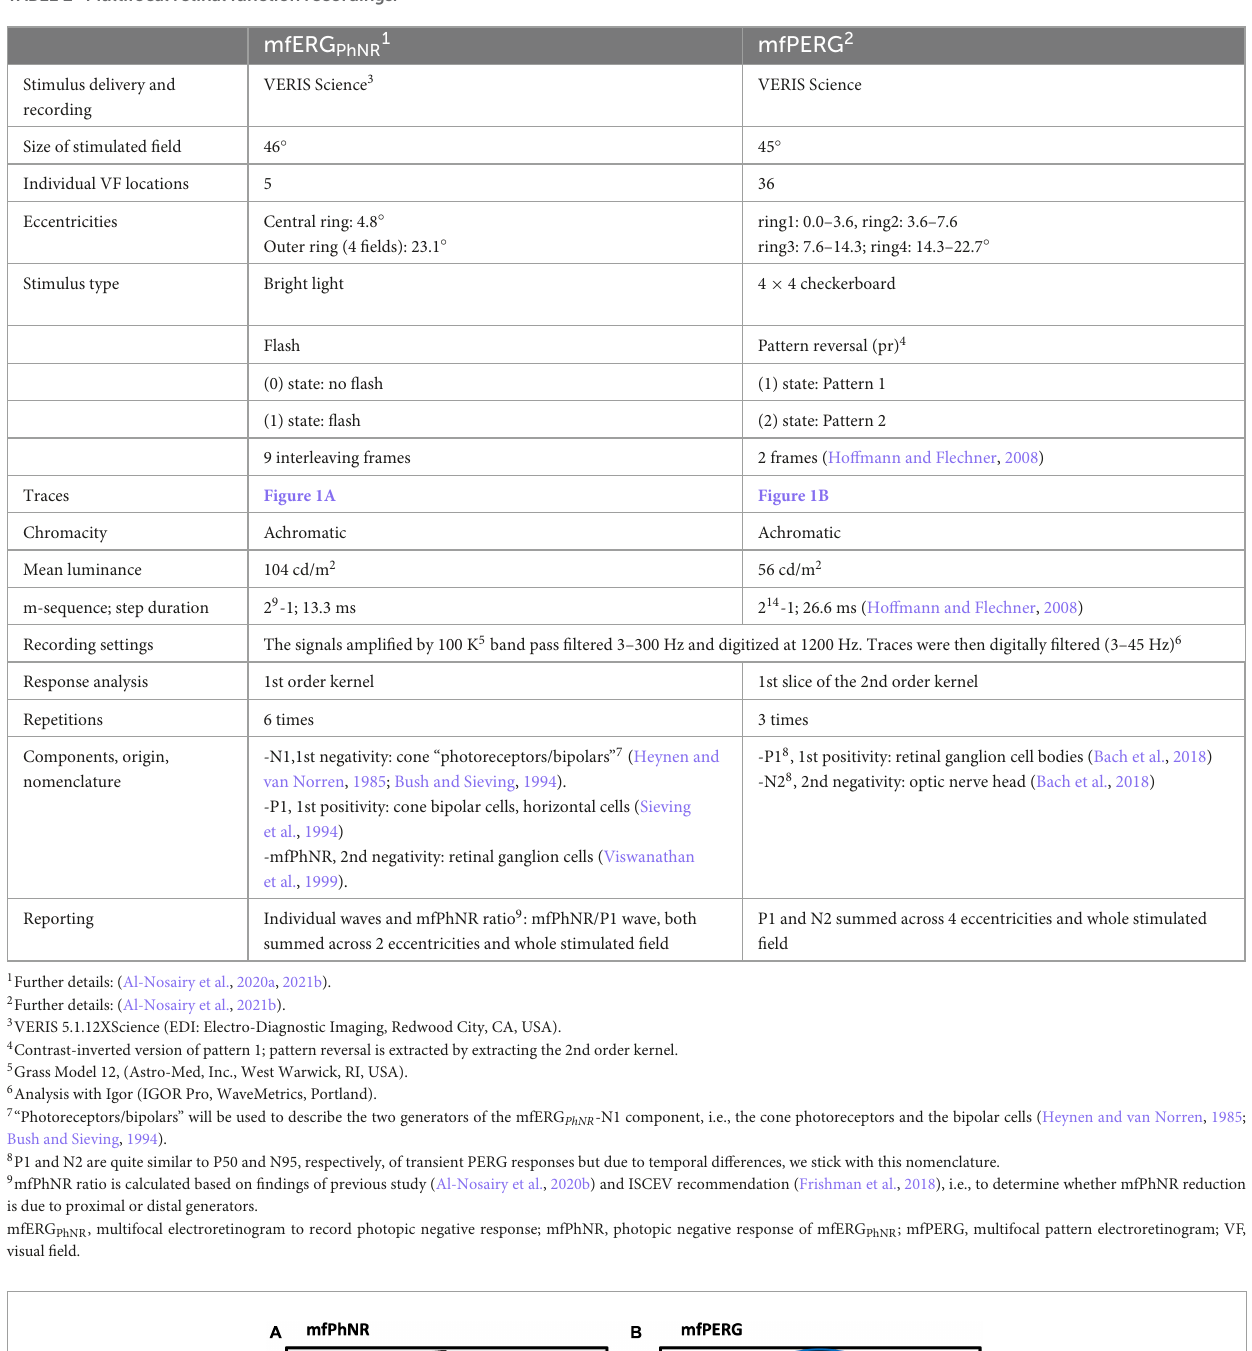
TABLE 2 Multifocal retinal function recordings.